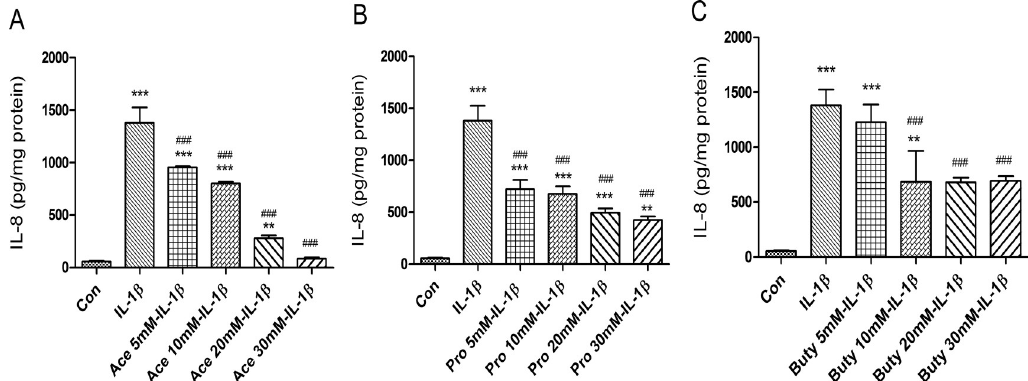
Fig 1. The effects of different doses of short-chain fatty acids (SCFAs) on prevention of IL-1 β -induced IL-8 induction in H4 cells. H4 cells were pretreated with or without SCFAs, (A) Acetate (5 − 30 mM), (B) Propionate (5 − 30 mM), and (C) Butyrate (5 − 30 mM) for 30 min before exposure to IL-1 β (1ng/ml) for 24 h. The secretion of IL-8 into the supernatants was determined by enzyme-linked immune sorbent assay (Elisa). The results are represented as the mean ± SEM of three independent experiments. One -way ANOVA and Tukey post hoc tests were used for statistic, n = 3. Differences compared to the control group were considered significant at �� p < 0.01, ��� p < 0.001; differences compared to the IL-1 β group were considered significant at ### p < 0.001. Acetate, Ace; propionate, Pro; butyrate, Buty.